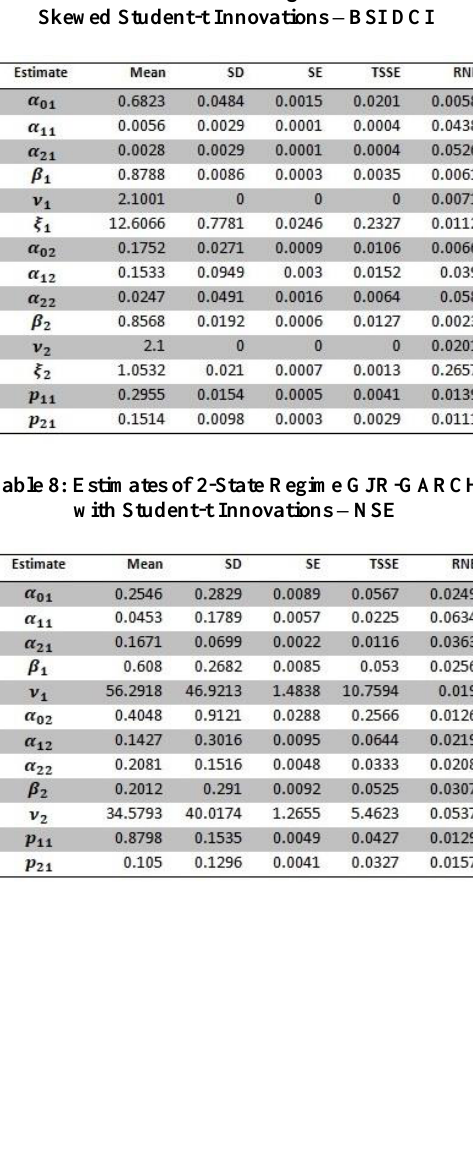
Table 7: Estimates of 2-State Regime E-GARCH with